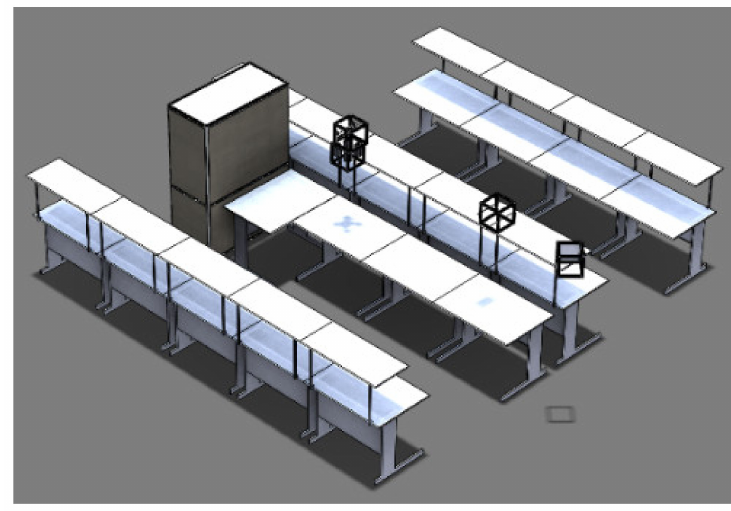
Figure 5. Perspective view of the target